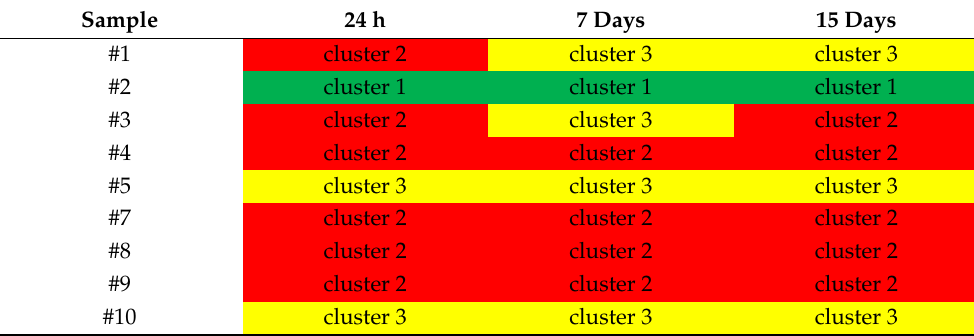
The colors mean the different